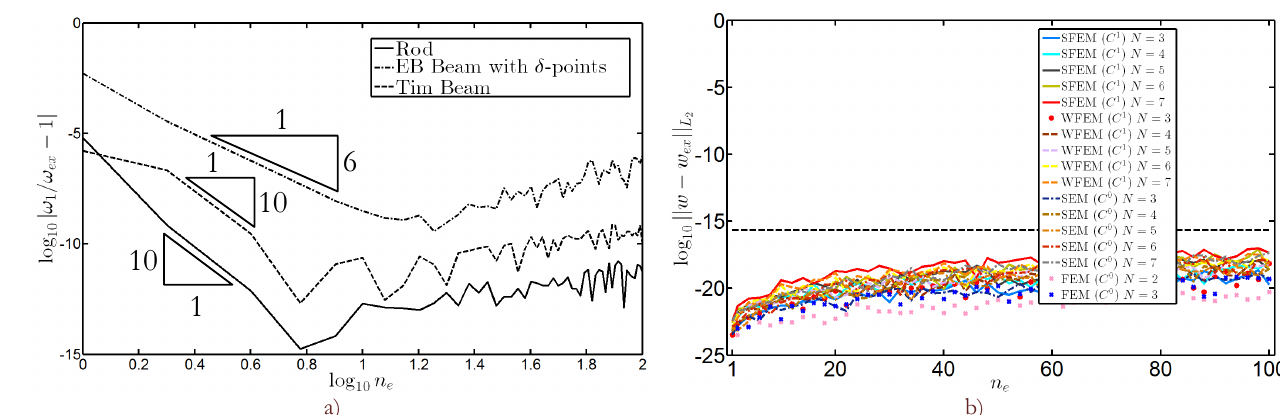
Figure 4: a) Relative error of the first frequency for various structural components with 7 N  for a CC Rod, a SS EB beam with  - points (1/2) and a CC Tim beam using PDQ basis functions and Leg-Gau grid distribution. b) Effect of the grid point number inside each element for the static analysis of a CC Rod using SFEM with PDQ basis functions and Leg-Gau grid distribution, WFEM and SEM with PDQ basis functions and Leg-Gau-Lob grid distribution and FEM with linear and quadratic shape functions. However, when a domain decomposition method is taken into account, it could not be necessary to use a polynomial of high degree inside each element, because a good approximation might be captured with a number of points less than 13 N 